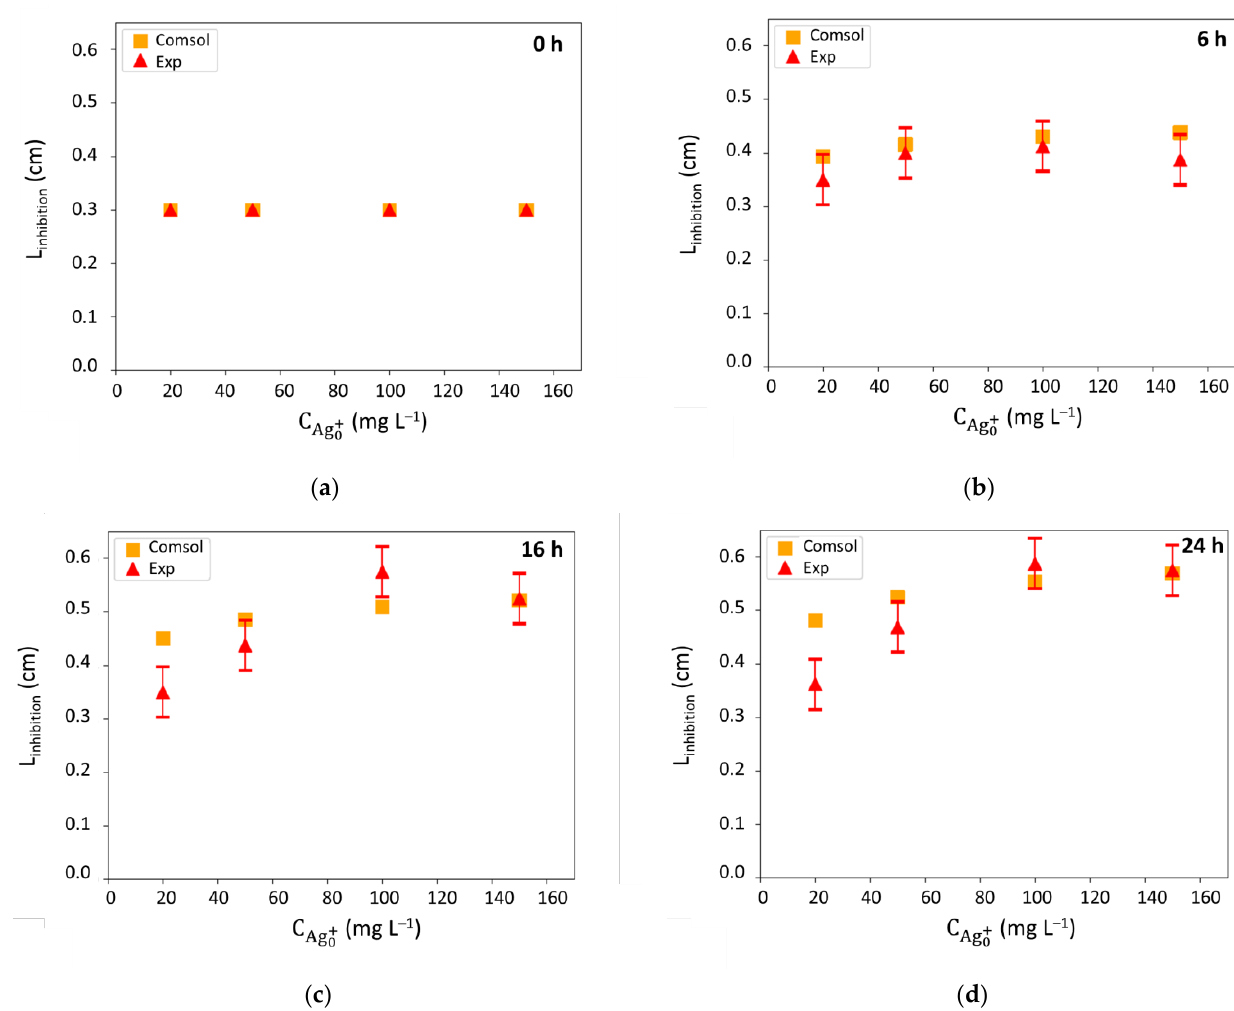
Figure 10. Inhibition halos radii (L inhibition ): comparison between experimental (Exp) and model (Comsol) results at ( a ) 0 h, ( b ) 6 h, ( c ) 16 h, and ( d ) 24 h.